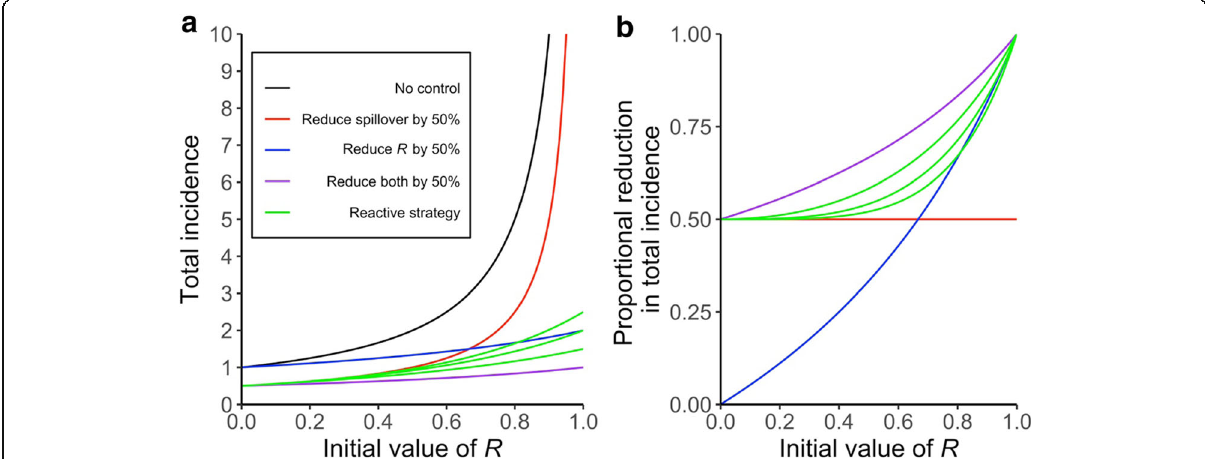
Fig. 3 Impacts of different control measures on incidence of a zoonotic infection with initial value of R (i.e. before control) between 0 and 1. Panel a illustrates the effects of control on the total incidence expected in a focal population, whereas panel b shows the proportional reduction in expected incidence when compared to the incidence level without control (black line). In a , the black line shows how the expected total incidence increases nonlinearly with R , for a fixed rate of zoonotic spillover. Colored lines show the total incidence that would result from interventions that cause 50% reductions in spillover transmission (red), human-to-human transmission (blue), or both types of transmission (purple). Green lines show the incidence resulting from a reactive intervention strategy, where effort is focused on reducing spillover transmission but is shifted to reducing human-to-human transmission once an outbreak is detected. The three green lines show the total incidence resulting when control is shifted after one, two, or three generations of transmission among humans, respectively from top to